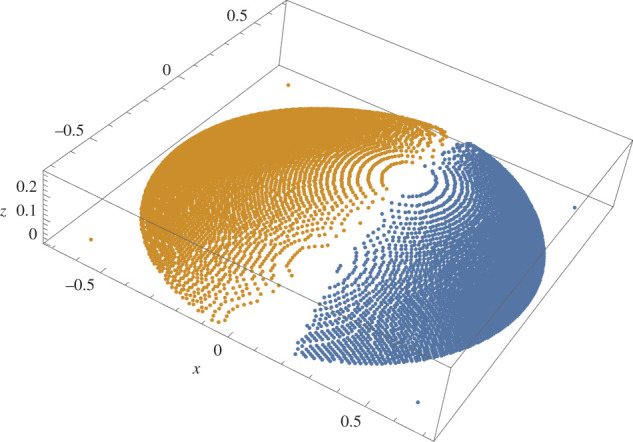
dy × dz mesh for the sample of figure 6. Mesh size: 0.01 × 0.005. Points x > xzmax in blue and x < xzmax in orange.